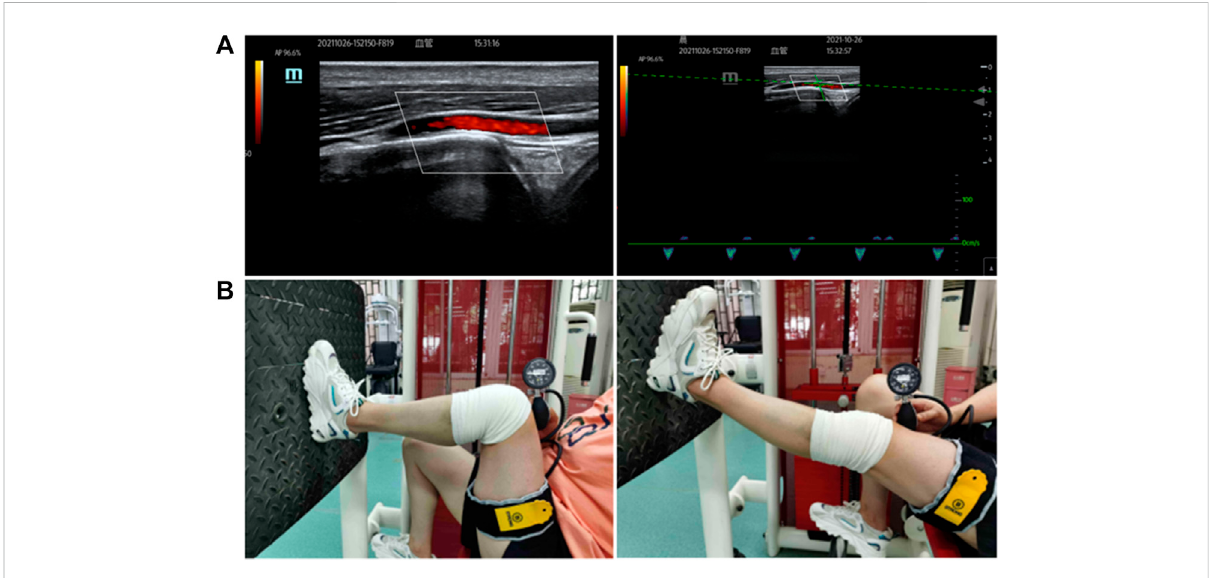
FIGURE 2 Schematicdiagram of blood fl ow restriction training [ (A) : ultrasound was used to measure limb occlusion pressure; (B) live image ofblood fl ow restriction